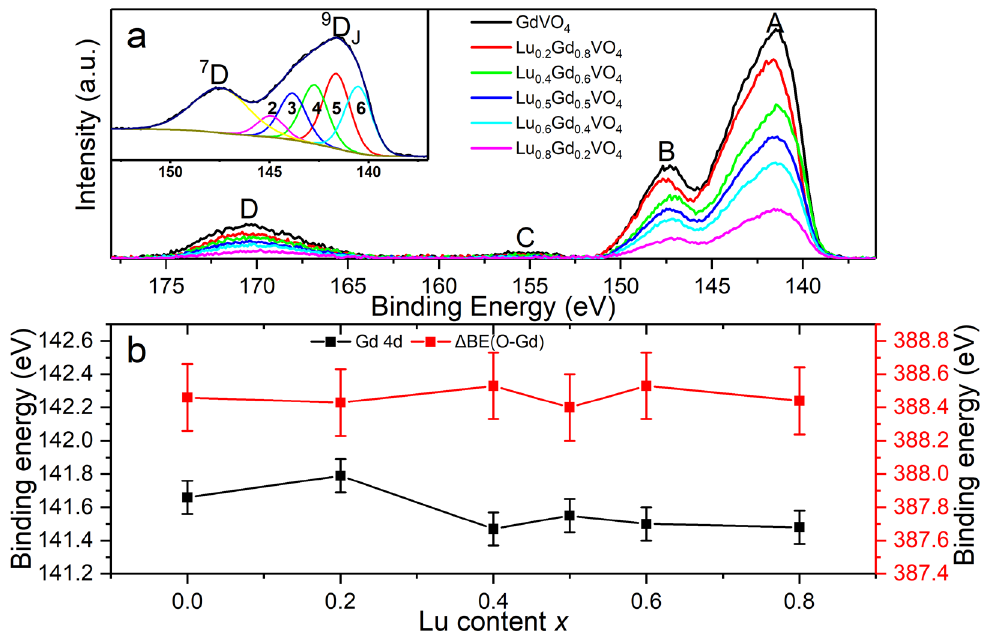
Figure 10. ( a ) Background-subtracted Gd 4 d XPS spectra of Lu x Gd 1 − x VO 4 ( 0 ≤ x < 1) and the deconvolution of peaks A and B of GdVO 4 (inset). ( b ) Binding energy of Gd 4 d 9 D 5 peaks and binding energy difference between O 1 s and Gd 4 d 9 D 5 versus the Lu content x . The error bars are 0.1 and 0.2 eV, respectively.